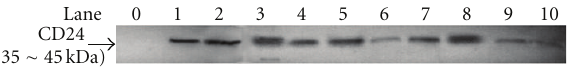
Figure 2: Western blot analysis for CD24 protein expression in retinoblastoma tissues, with non-neoplastic retina as control. The picture shows that CD24 was negative in non-neoplastic retina (lane 0), strongly expressed in 5 (83.3%, lanes 1 ∼ 5) and faintly expressed in 1 (16.7%, lanes 6) high-risk tumors, whereas it was strongly expressed in 2 (50.0%, lanes 7 ∼ 8) and faintly expressed in 2 (50.0%, lanes 9 ∼ 10) low-risk